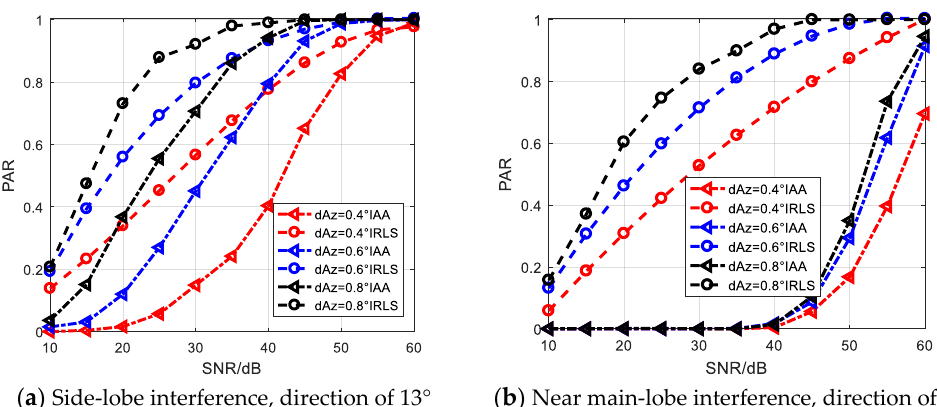
Figure 7. PAR (double target with interference, INR = 60 dB).